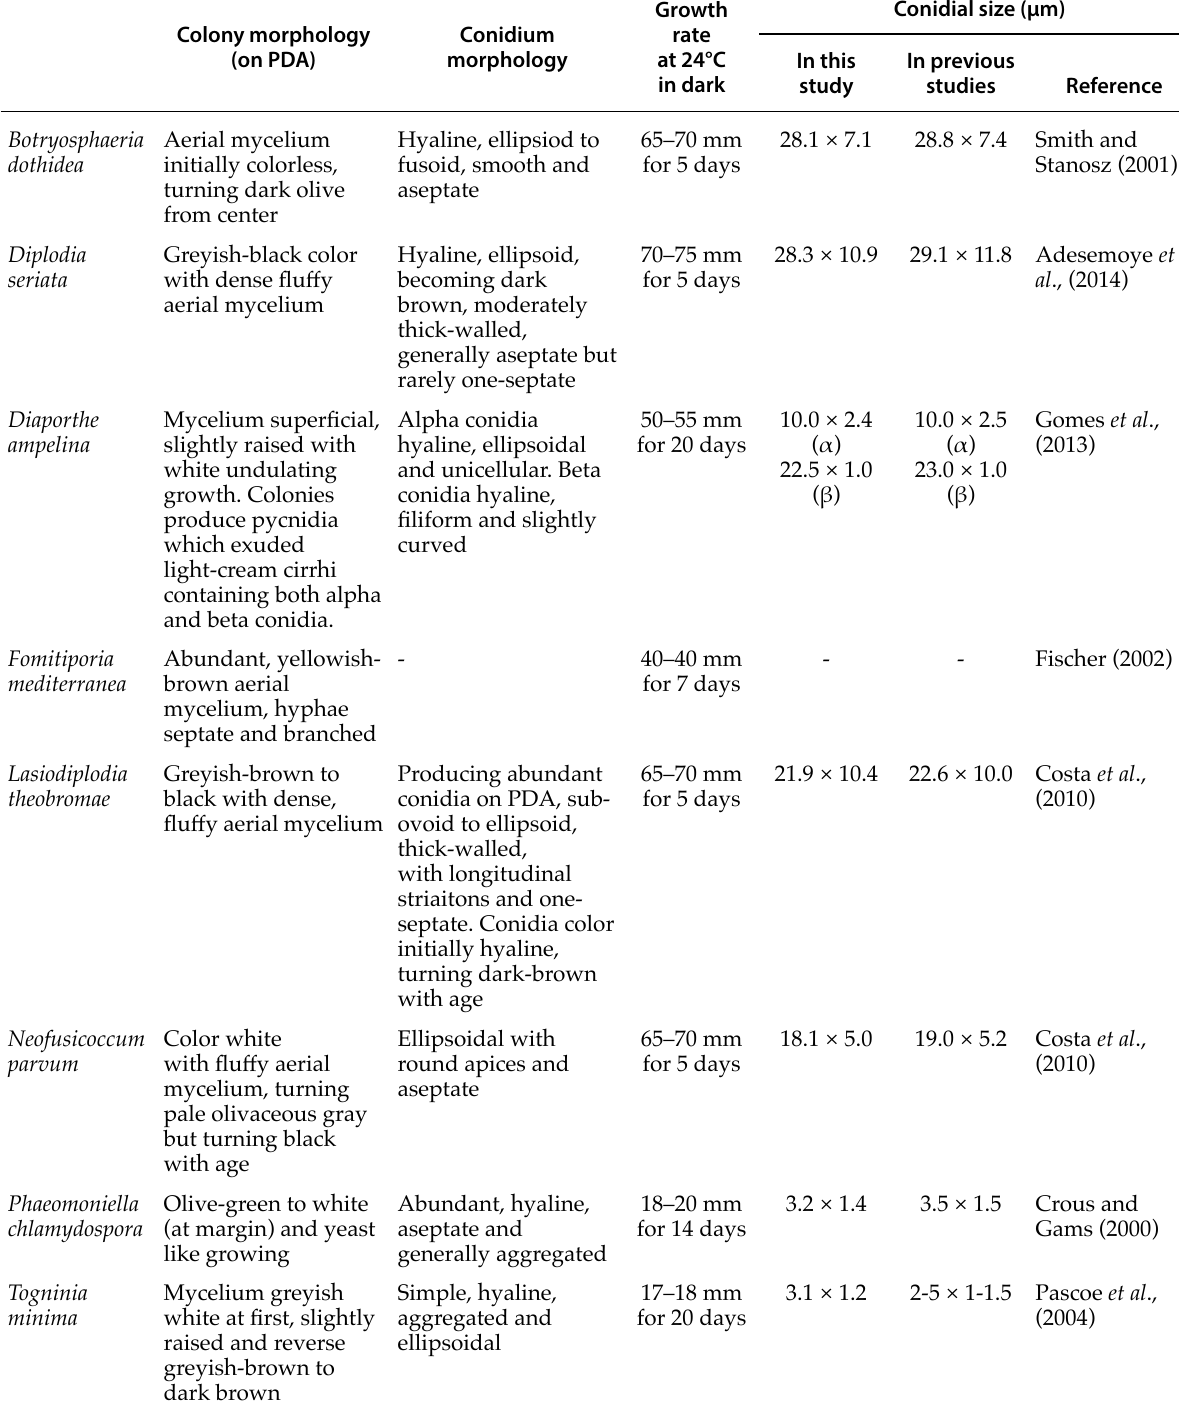
Table 2. Morphological characteristics of the GTD fungi used in this study